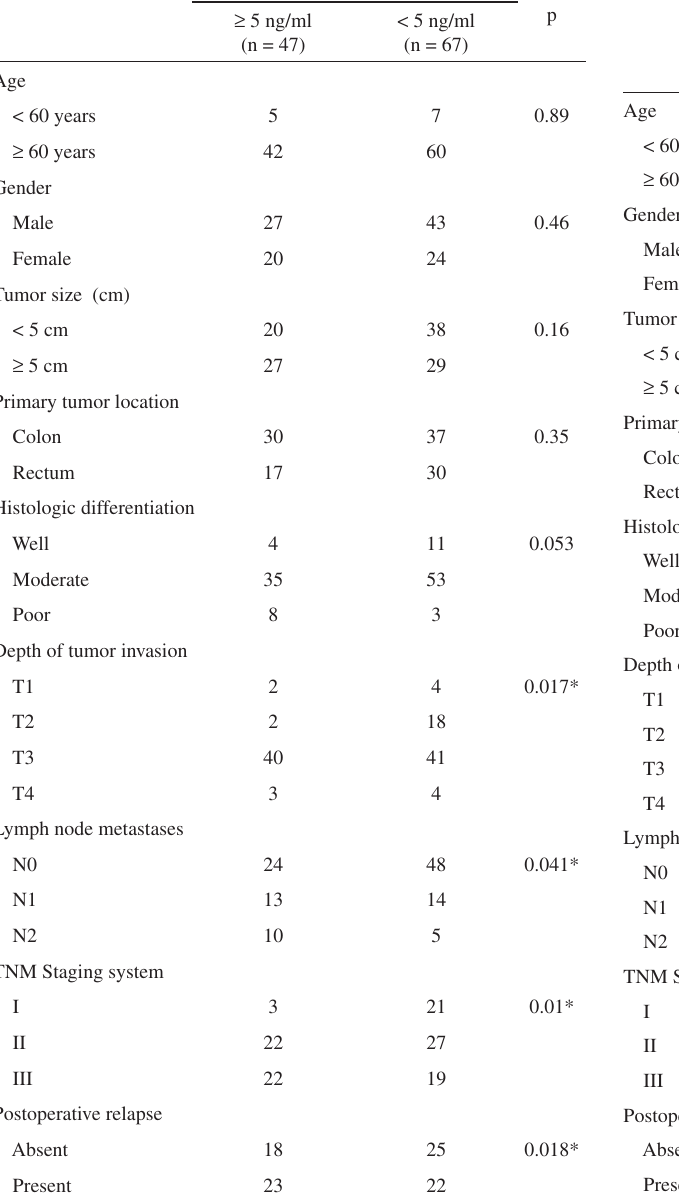
Table 2 - Demographic and clinical features, and postop- erative CEA levels of patients with abnormal preoperative CEA